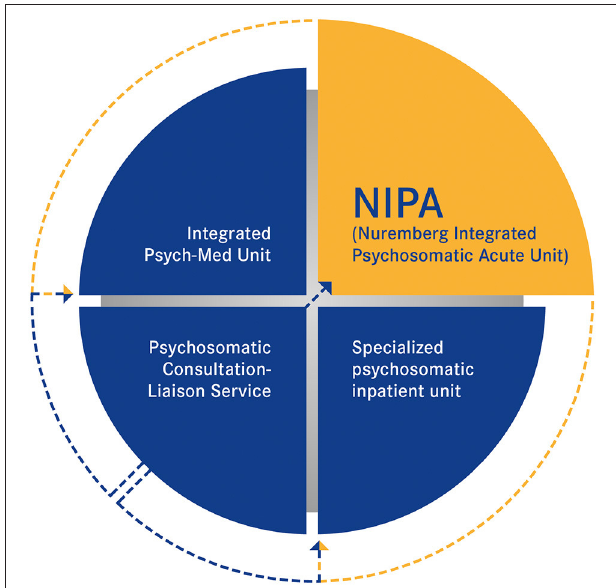
FIGURE 1 | Illustration of the treatment gap in the biopsychosocial care of psychosomatic patients in Germany. NIPA represents an important component for rounding off the infrastructure in healthcare for the complex medically ill. Referral is made by the CL service from the internal medicine wards of general hospital. NIPA, in turn, can be a “door opener” to further psychosomatic treatment programs if